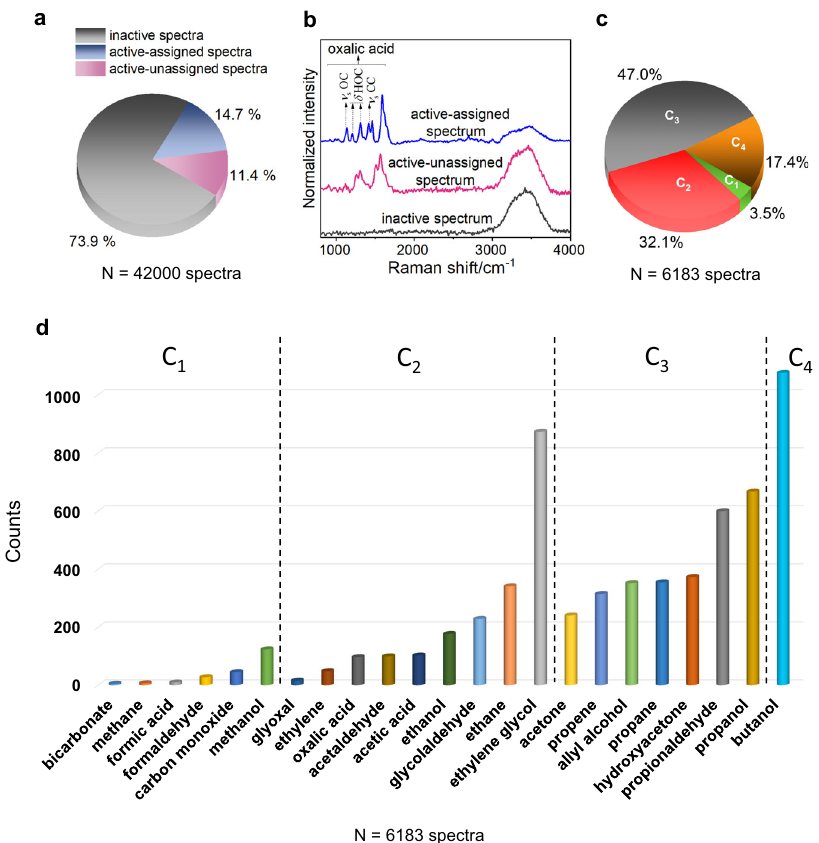
Fig. 4 Pro fi le of surface species observed in CO 2 RR by in situ nanoscale SERS. a Pie chart showing the percentage distribution of inactive SERS spectra, active spectra that were assigned to a species in the database, and active spectra that were unassignable. This distribution was obtained by an analysis of 42,000 in situ SERS spectra collected from 40 individual Ag NP scatterers in 12 CO 2 -saturated H 2 O (1) under plasmonic excitation. b Representative examples of SERS spectra in each of these three classes, plotted in a vertically stacked manner. The broad band at ca. 3400 cm − 1 in all three spectra is due to Raman scattering from H 2 O (1) in the medium. The active, assigned SERS spectrum shown as an example captured oxalic acid, the major vibrational modes of which are labeled by the following symbols: ν s — symmetric stretching; δ — bending. SERS spectra were baseline-subtracted, subjected to smoothing by a Savitzky – Golay fi lter with a window of 5 points and a polynomial of order 3, and normalized to a [0, 1] scale prior to plotting in a vertically stacked manner. The baseline was determined by polynomial fi tting. c Pie chart showing the percentages of active, assigned spectra that captured a C 1 , C 2 , C 3 , and C 4 species. d Bar plot showing for each surface species the number of detection events across the set of active, assigned spectra. Each species is shown by a bar of a different color. The species are grouped into C 1 , C 2 , C 3 , and C 4 categories; within each category, they are listed in the order of their prevalence. N in a , c , and d represents the total number of spectra that led to the plot. Source data are provided as a source data fi le. NATURE COMMUNICATIONS| (2021) 12:2612